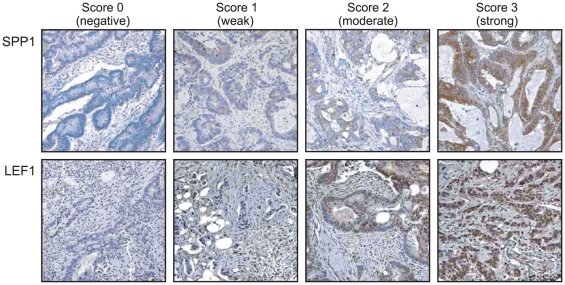
Immunohistochemical staining and assessment of SPP1 or LEF1 in representative core sections from the CRC tissue microarray.Staining of SPP1 and LEF1 were respectively visualized in the cytoplasm and nuclei of cancer cells (X 400 magnification).